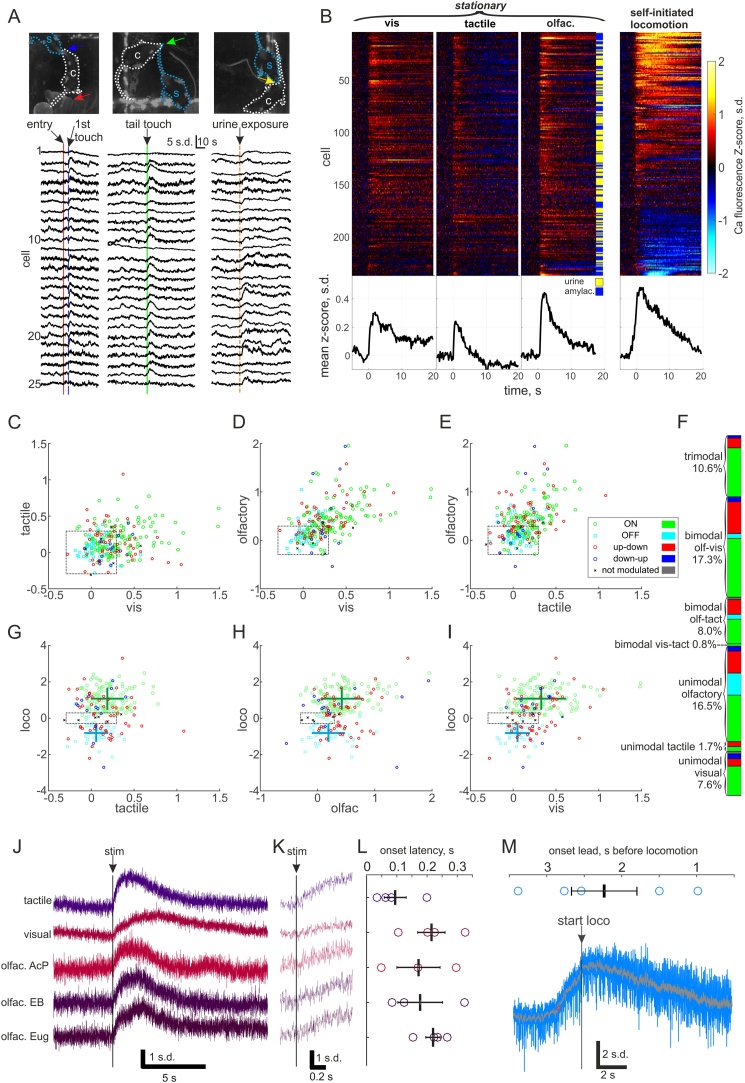
Sensory responses in HONs.A, Example natural sensory responses to social stimuli in HONs recorded with miniature endoscope in freely moving male subject (s, blue dashed outline) while it was in the arena with a female conspecific (c, white dashed outline). Arrows indicate locations of natural stimuli. In left panel conspecific enters arena from handler’s hand (red arrow) and moves to touch snouts with subject (blue arrow). In middle panel conspecific investigates subjects tail, touching it (green arrow) and causing subject to stop feeding and turn around. In right panel subject is investigating conspecific’s rear when conspecific begins to urinate (yellow arrow). B, Head-fixed sensory responses from 237 cells from 4 mice, averaged from 5 to 11 trials where mice remained stationary (three panels from left). Vis = visual, blue LED flash; tactile, 30 psi pressure pulse applied to left side abdomen; olfac. = olfactory, odor pulse (rapid valve switch between empty vial and odor vial with no change in pressure) to snout containing amylacetate (amylac.) or urine pooled from 5 females in different cages. Right panel contains averaged locomotion activity profiles aligned to self-initiated movement onset from each cell from 5 to 22 locomotion bouts outside sensory stimulation trials. Black traces at the bottom of each cell raster are averages across all cells. C–E, Scatter plots of response amplitudes (mean signal from 1 to 4 s after stimulus) of all cells to two modalities in each plot, coloured by the locomotion subtype (legend in E). Dashed black boxes denote the extrema of null-responses (quantified response amplitude to a 77 dB 10 kHz sound stimulus that did not cause a detectable response), i.e., only responses outside the box should be considered meaningful. F, Proportions of responsive cells out of all cells coloured by locomotion subtype and grouped by the number of response modalities. G–I, Scatter plots of response amplitudes and locomotion profile averages (see methods). Legend as in E. Green and cyan crosses denote mean ± s.d. for ON and OFF cell populations respectively (sensory responses: G, ON 0.19 ± 0.19, OFF 0.06 ± 0.14; H, ON 0.42 ± 0.36, OFF 0.19 ± 0.29; I, ON 0.33 ± 0.29, OFF 0.05 ± 0.15) which were significantly different for all modalities (P < 0.001 Wilcoxon rank sum test). J, Fiber photometry responses of the orexin population to tactile, visual and three different olfactory stimuli (AcP, acetophenol; EB, ethylbutyrate; Eug, eugenol). K, Expanded view from J. L, Quantified latency from stimulus onset to response onset tactile (95 ± 36 ms), visual (172 ± 72 ms) and three different olfactory stimuli (acetophenol, 178 ± 74 ms; ethylbutyrate, 220 ± 24 ms; eugenol, 214 ± 45 ms) in averaged traces (5–20 trials) for 4 mice for all stimuli except AcP and EB from 3 mice. M, Onset lead delay from fiber photometry signal increase to movement onset (2230 ± 440 ms) from 11 to 28 locomotion bouts from 5 mice. Blue background trace is unfiltered and black trace is smoothed with a 100-sample moving average.